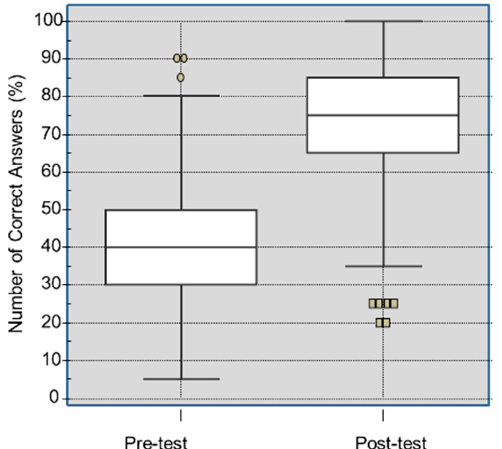
Figure 2. Distribution of students according to the percentage of correct answers in the pre-test and post-test (Wilcoxon test, p < 0.001). The difference in correct answers between the pre-test and the post-test had a normal distribution, with a median of 6.5 points. Points: pre-test outliers and squares: post-test outliers